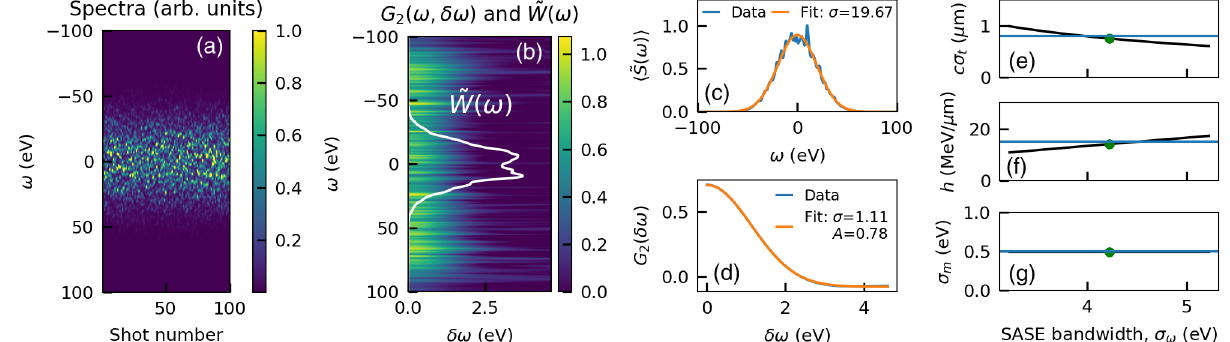
˜ S ð ω Þi (c). Fitting Gaussian functions to each of (e), h (f), and σ (g) as functions of σ ω [Eqs. (7) and (9)]. t m